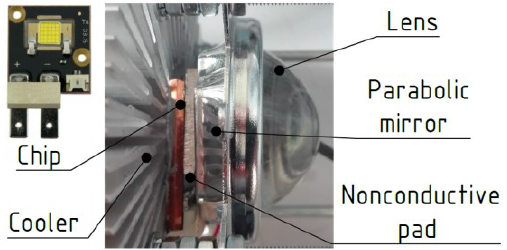
Fig. 3. The optical parts of the light sources C and D.